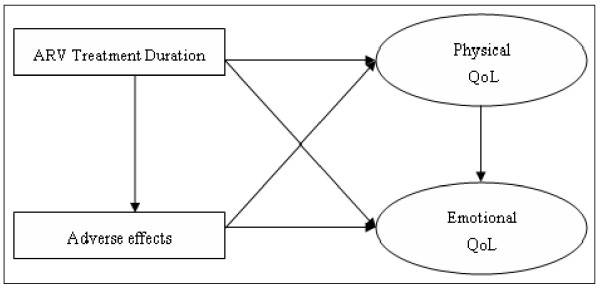
The conceptual model, showing the hypothesized relationships between ART duration, adverse effects, and physical and emotional quality of life (QoL).